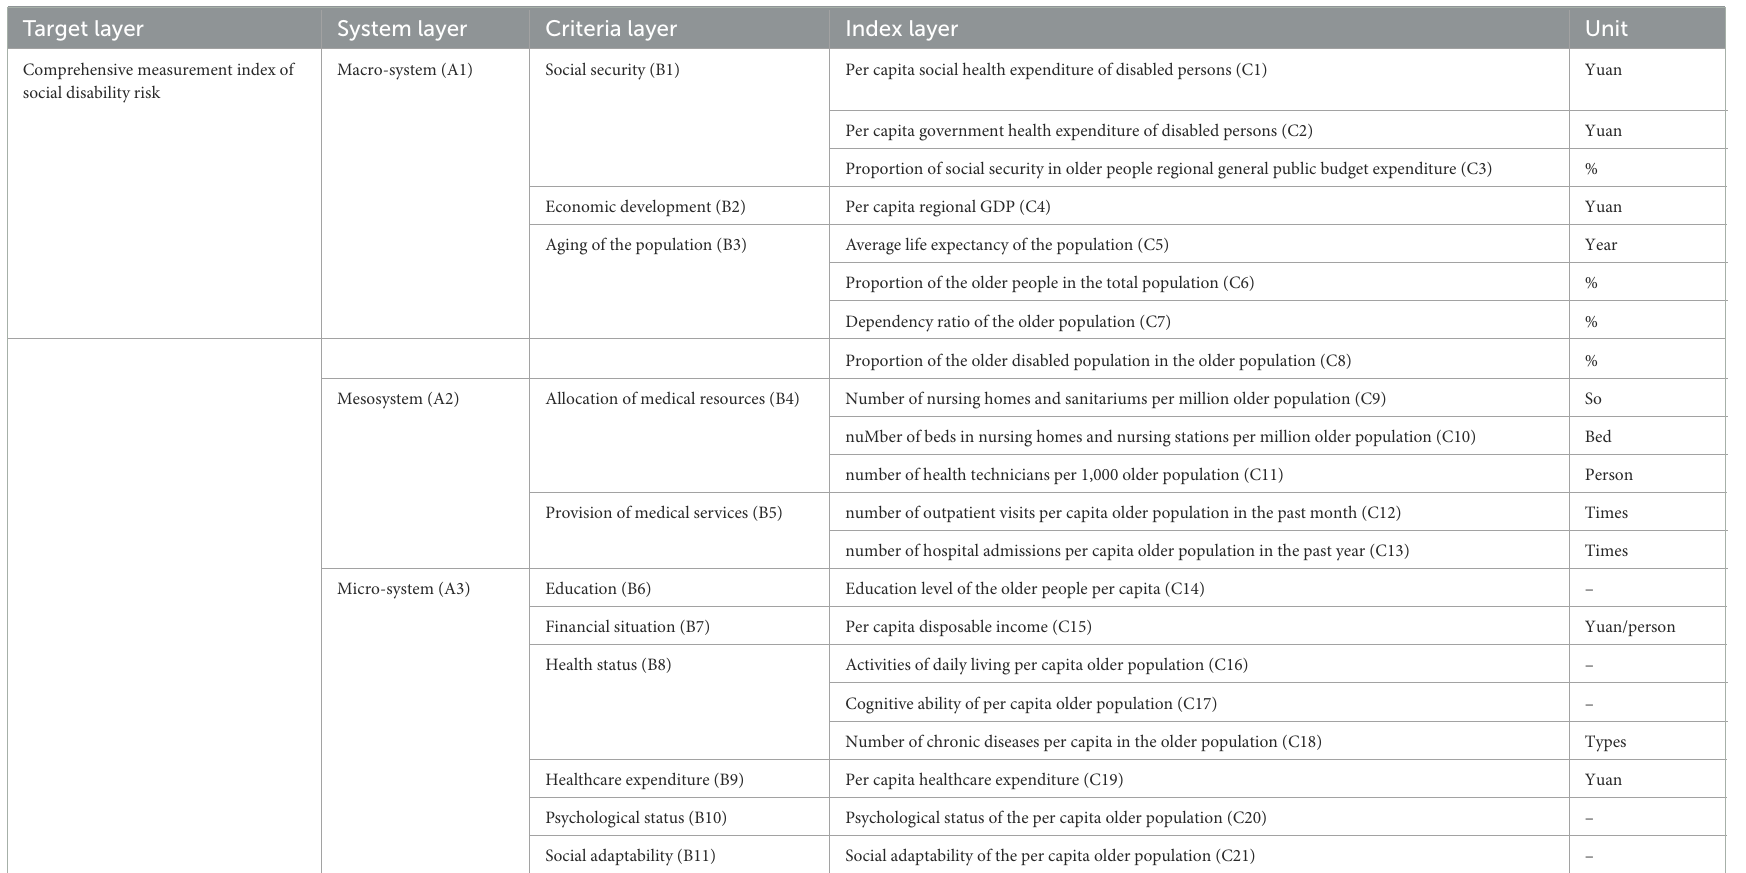
TABLE 1 Measurement index system of social disability